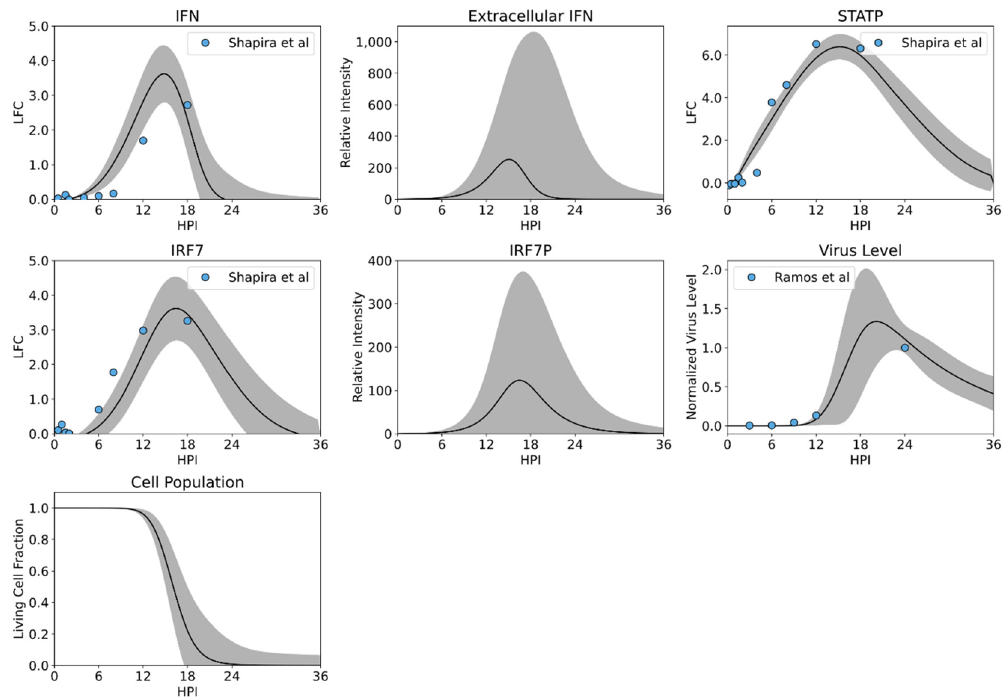
Figure 2. Model Simulations. The solid black lines are the trajectories that best fit the training data, as quantified by the SSE. The shaded area is ± 1 standard deviation of the best 1000 parameter sets’ simulations. LFC = Log 2 Fold Change of gene expression versus control.